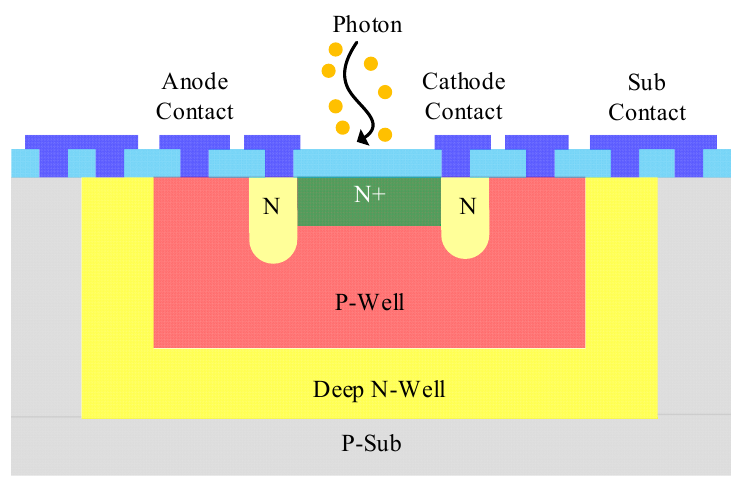
Figure 7. Cross section of a CMOS single photon avalanche diode